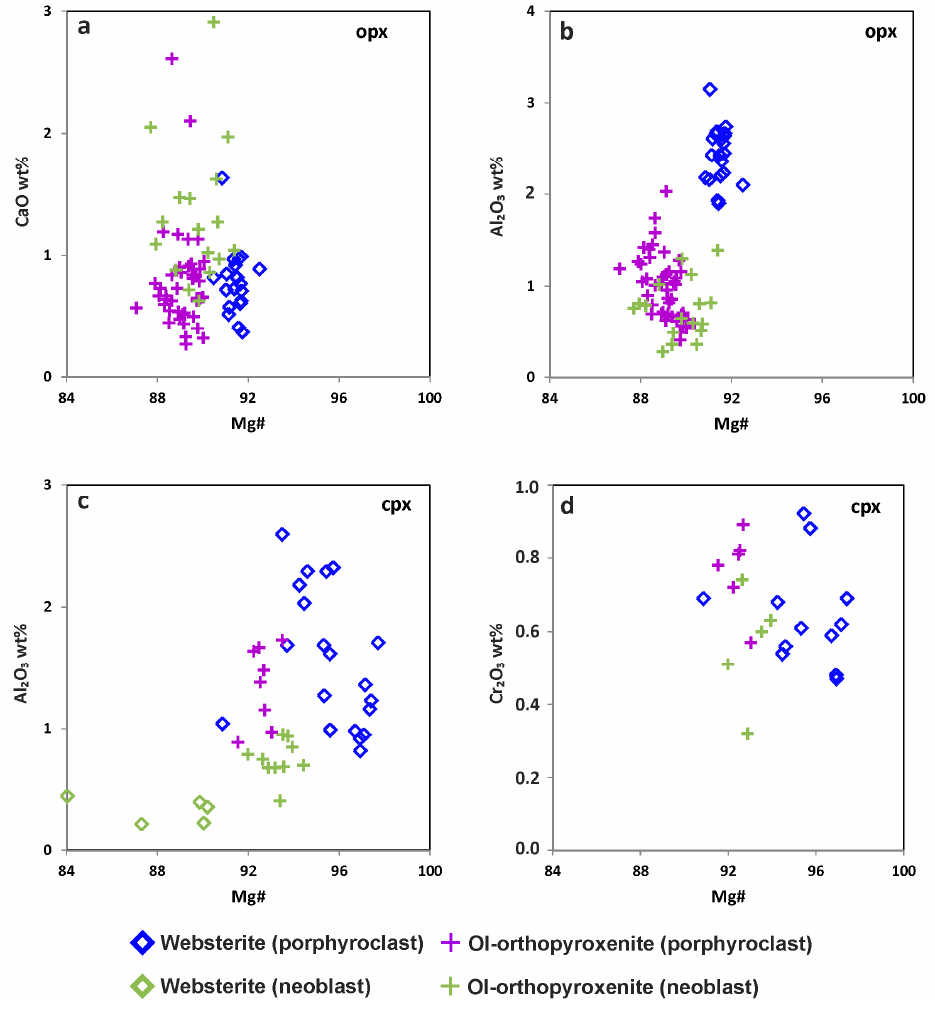
Figure 3. Orthopyroxene and clinopyroxene compositions of the Veria-Naousa pyroxenites: ( a ) CaO vs. Mg# in orthopyroxene; ( b ) Al 2 O 3 vs. Mg# in orthopyroxene; ( c ) Al 2 O 3 vs. Mg# in clinopyroxene and ( d ) Cr 2 O 3 vs. Mg# in clinopyroxene.